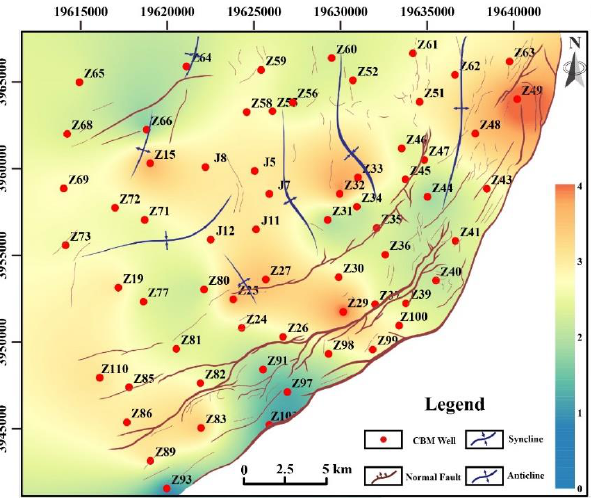
Figure 9. V/I isovalue map of the No.3 coal seam in the Zhengzhuang field (V = vitrinite, I = Inertinite).